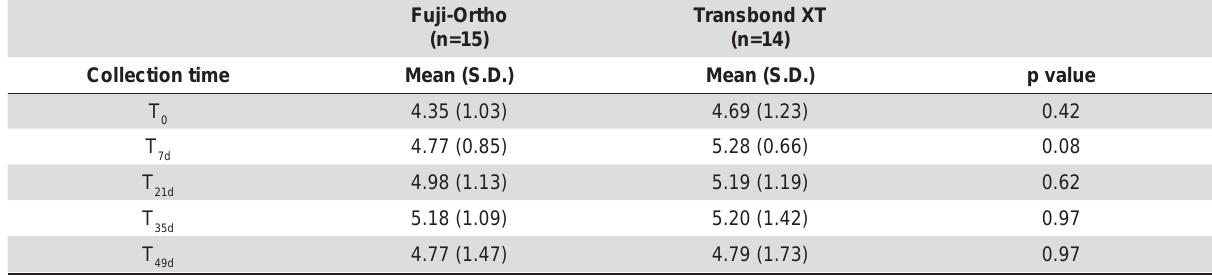
T = before bracket bonding. T 0 results of the Student’s t-test for comparison of the materials at each collection time.